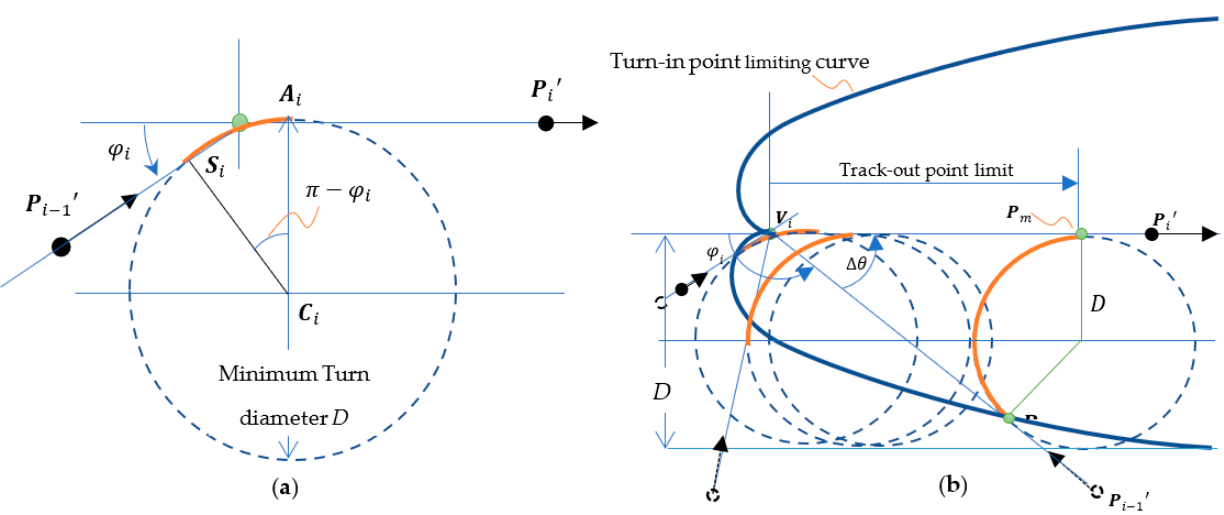
Figure 4. ( a ) Minimum turn diameter D and ( b ) the critical turn-in and track-out points of corner- ing